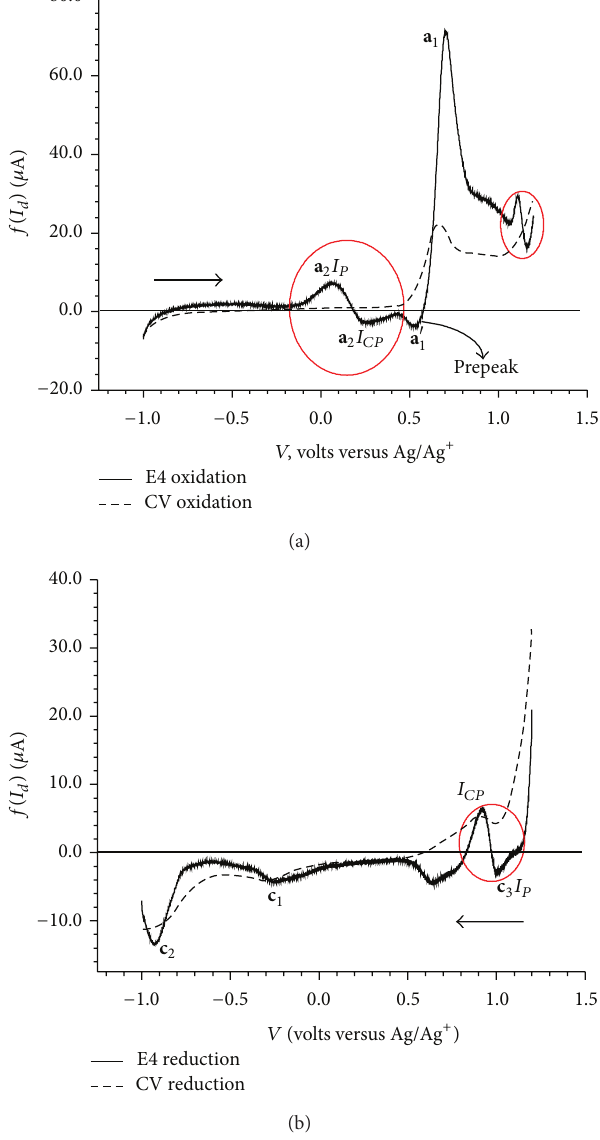
Figure 5: Plots for diffusion current 𝐼 𝑑 for BB: (a) oxidation process and (b) reduction